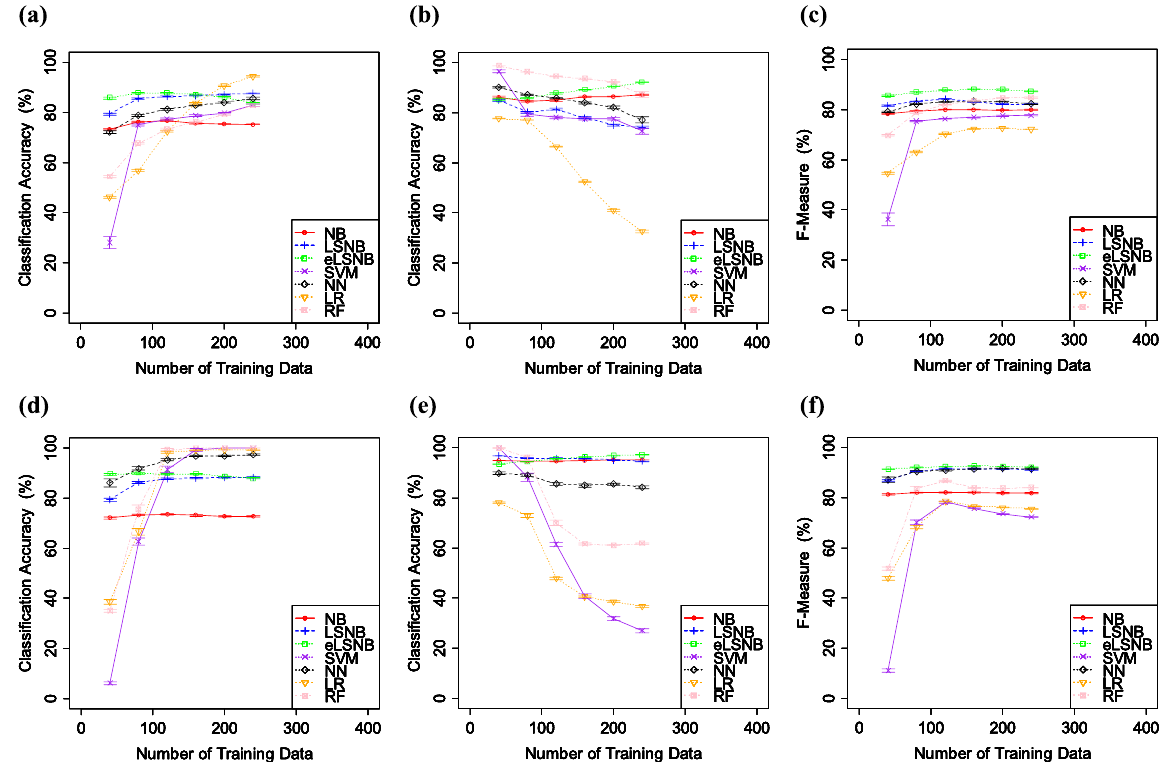
Figure 7. ( a ) spam classification accuracy, ( b ) ham classification accuracy ( c ) F-measure values for SpamAssassin. ( d ) spam classification accuracy, ( e ) ham classification accuracy and ( f ) F-measure values for Ling-Spam. The number of ham training data points was predefined to 100. Error bars indicate the standard